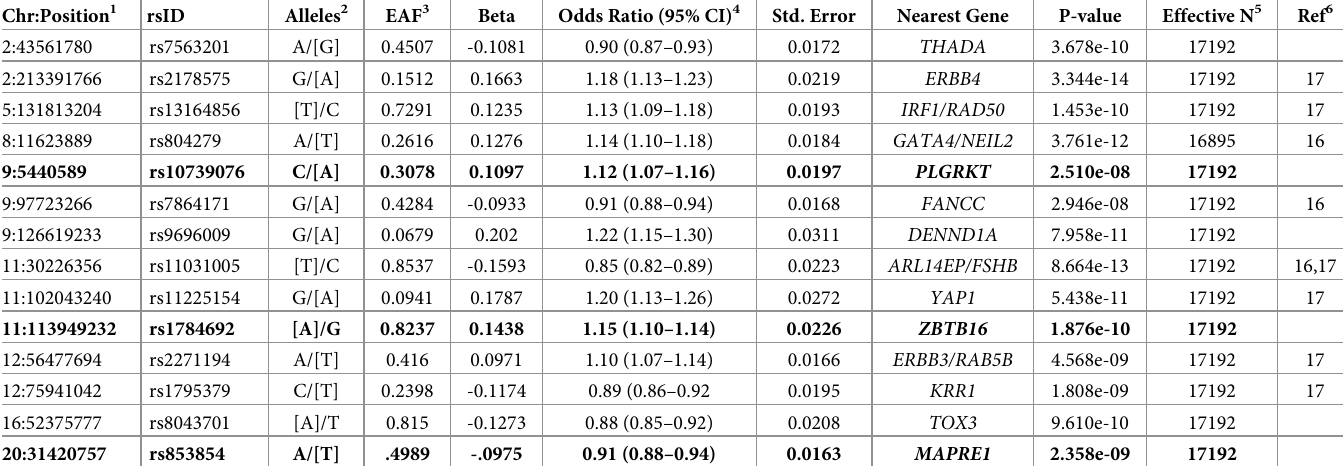
Table 2. The 14 genome-wide significant variants associated with PCOS in the meta-analysis.